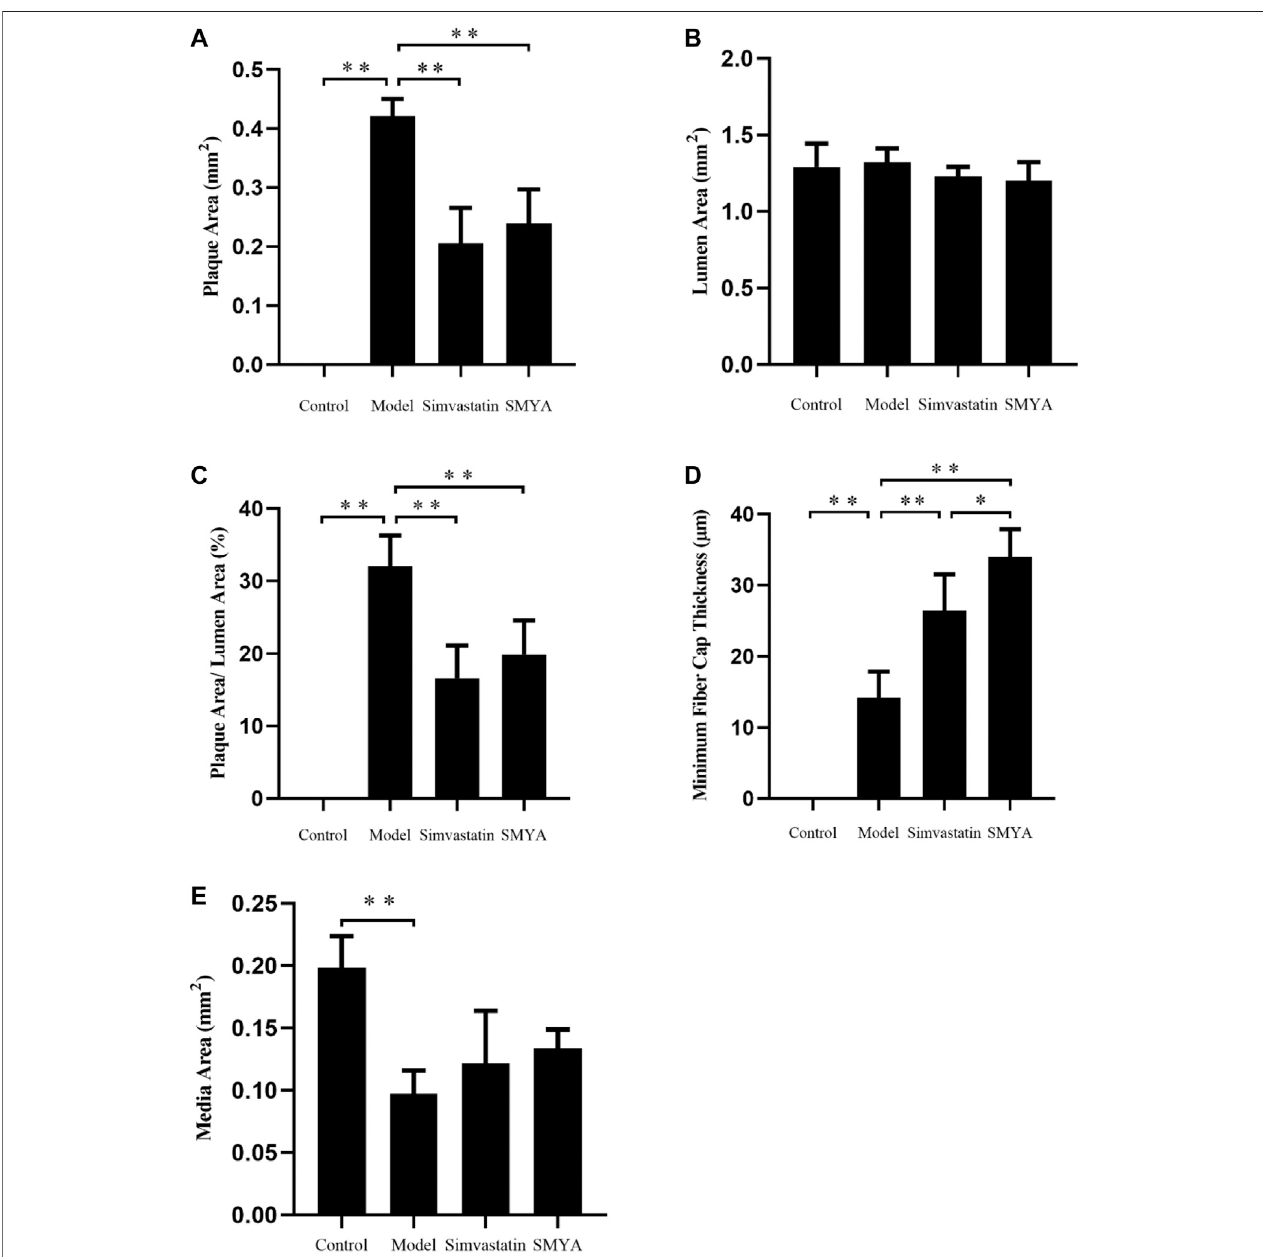
FIGURE3| QuantitativeanalysisofSMYAonplaqueofaorticroot. (A) plaqueareaeachgroup; (B) lumenareaeachgroup; (C) plaquearea/lumenareaeachgroup; (D) minimum fi ber cap thickness each group; (E) media area each group. Data are expressed as mean ± SD. *p < 0.05, **p < 0.01.